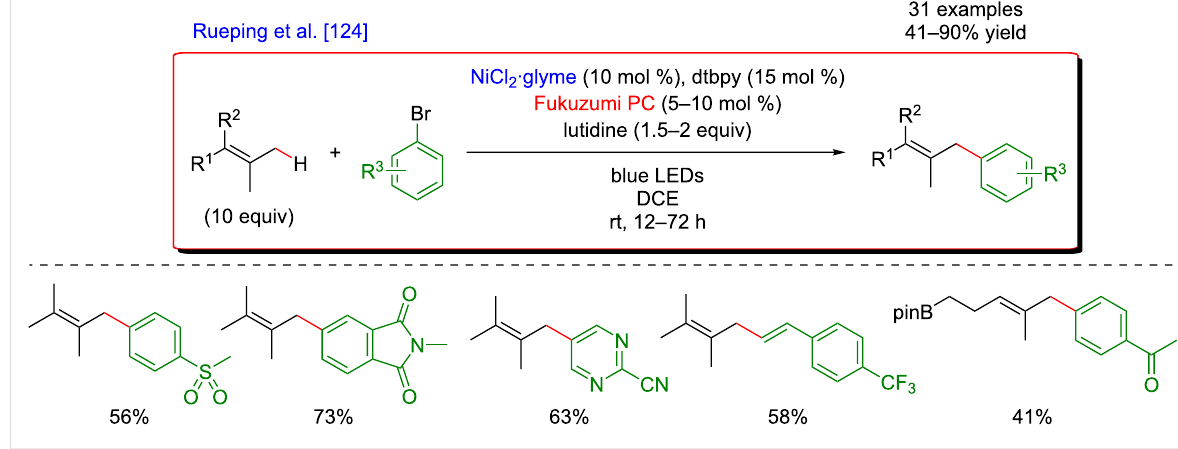
Figure 71: Allylic C(sp 3 )–H activation via dual Ni/photoredox catalysis.